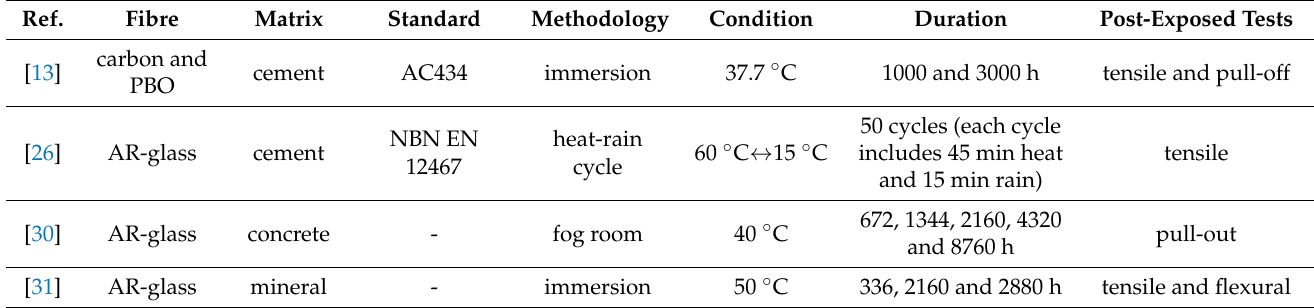
Table 3. Summary of literature on immersion in hot water or exposure to high-temperature vapour. Ref.